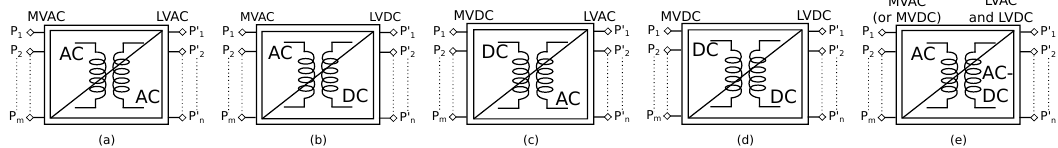
Figure 4. MIMO building blocks for formation of SST [20,39]: ( a ) MIMO SPSS AC (cid:107) AC SST, ( b ) MIMO SPSS AC (cid:107) DC SST, ( c ) MIMO SPSS DC (cid:107) AC SST, ( d ) MIMO SPSS DC (cid:107) DC SST, and ( e ) Hybrid-port MIMO SPSS AC (cid:107) AC-DC SST.